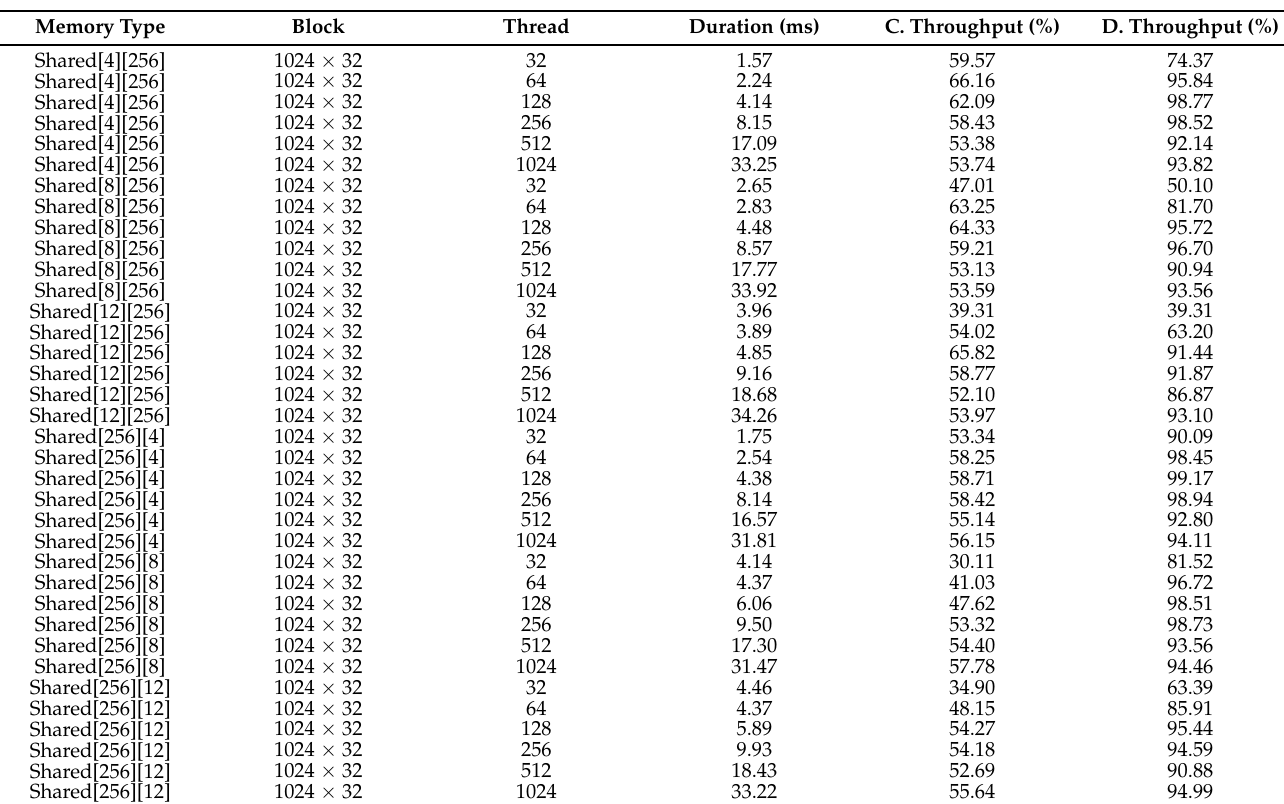
Table 9. Performance of the extended Sbox using shared memory implementation (C.: compute, M.: